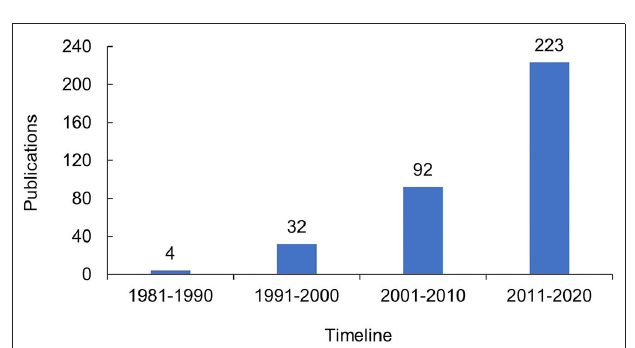
FIGURE 2 | Timeline of publications on fog water collection, segregated by decade.